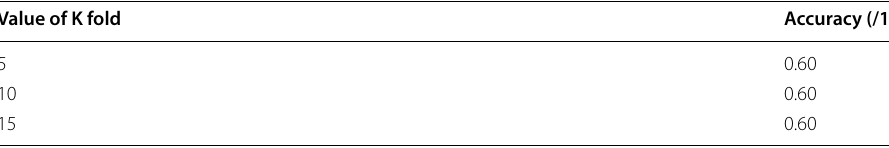
Table 9 Naïve Baye model accuracy result Value of K fold